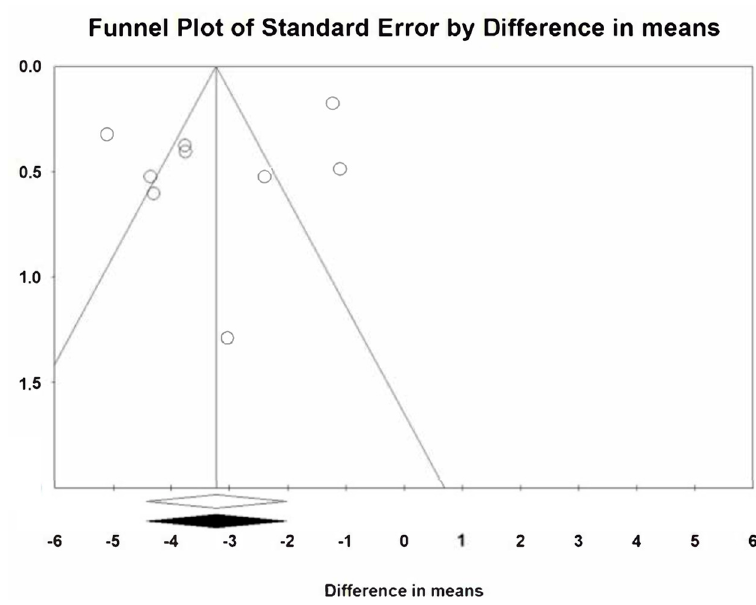
Figure 7. Publication bias at two weeks.